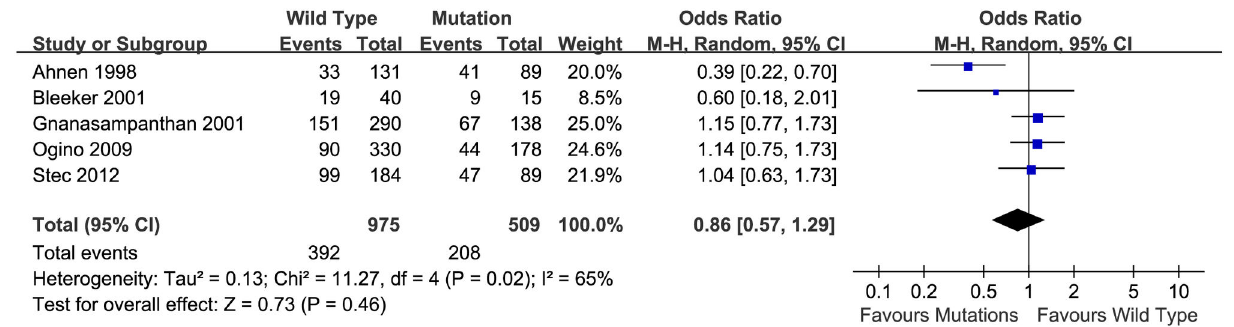
Figure 4. 5-year overall survival rate of wild type and mutant K-ras gene in patients received chemotherapy, with Random Model.